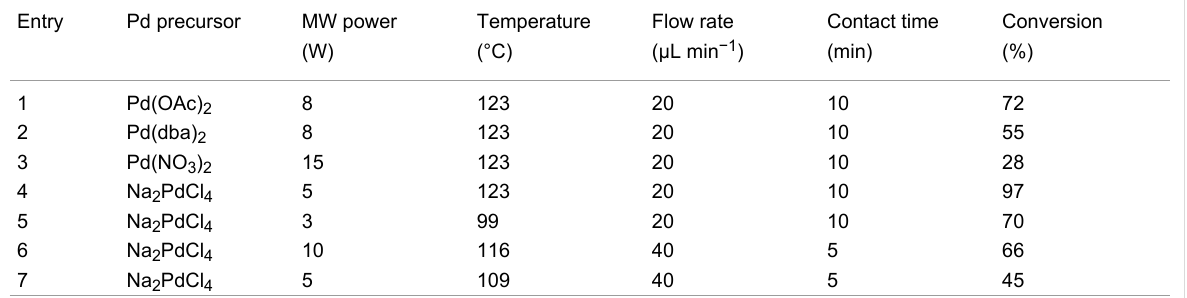
Table 2: Reactivity of Pd-monolith-3.2 synthesized using different Pd precursors in the Suzuki–Miyaura reaction between bromobenzene and phenyl- boronic acid under continuous flow conditions. a Entry